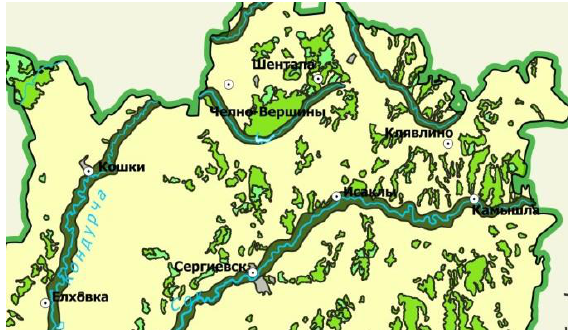
Figure 10. Fragment of the final vegetation map of Samara